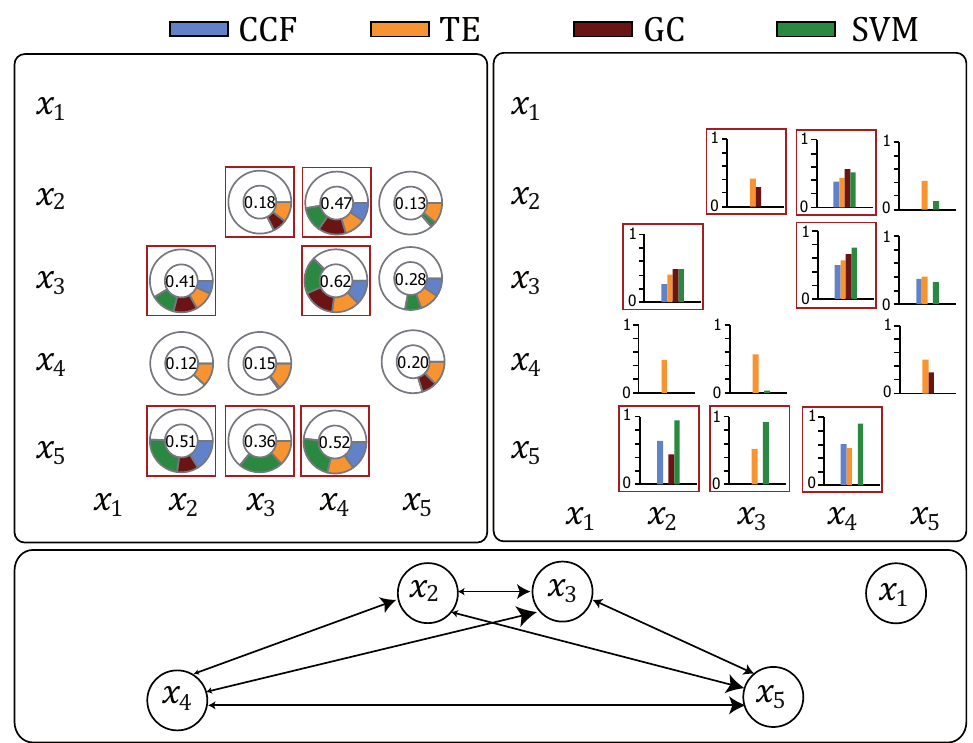
Figure 6. Causal matrices for the laboratory plant. The red squares describe the expected causal dependencies to be detected by the